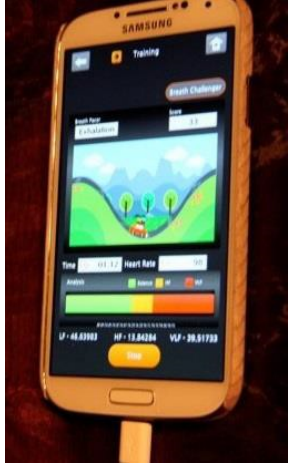
Figure 5. ResCalm. Figure 5.